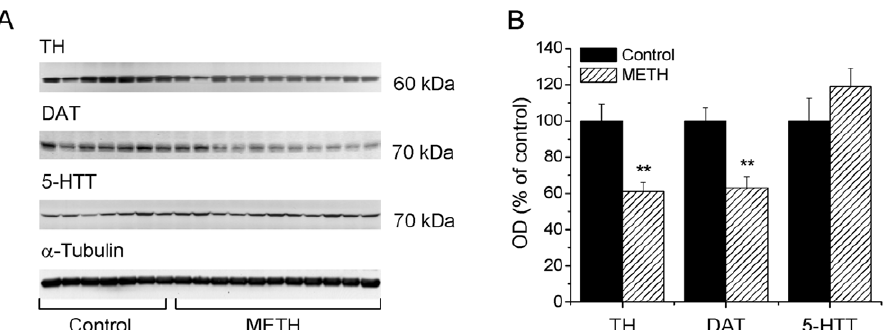
Figure 4. METH self-administration causes reductions in DAT and TH protein levels in the striatum. (A) Representative immunoblots show expression of TH, DAT and 5-HTT protein levels in the striatum 14 days after last METH self-administration session. (B) Quantitative analyses of immunoblots reveal significant decreases in TH and DAT, but no change in 5-HTT expression in the METH-treated rats. Data presented as mean 6 SEM. ** p , 0.01 vs control. Data were analyzed by ANOVA followed by PLSD, n=7 2 11 per group.